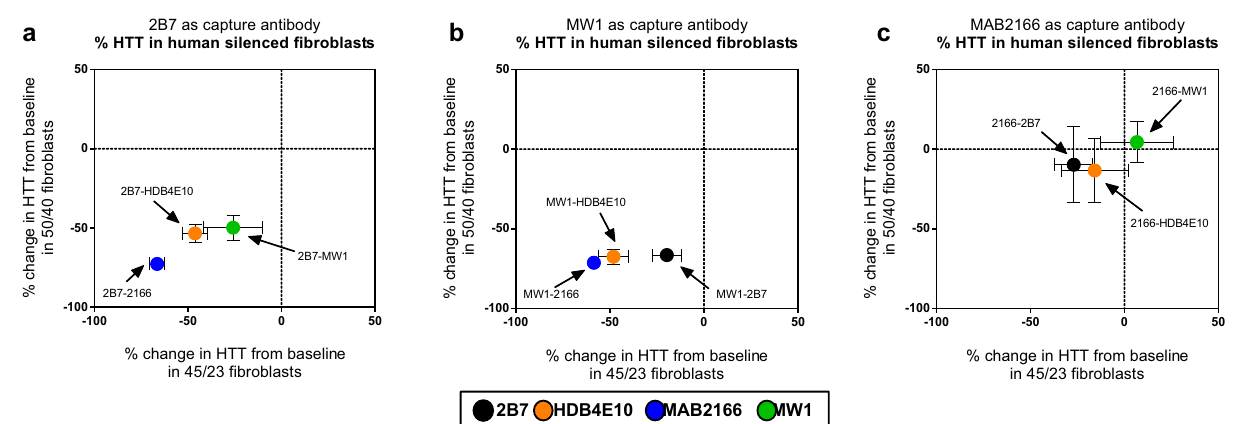
2B7 as capture antibody % HTT in human silenced fibroblasts